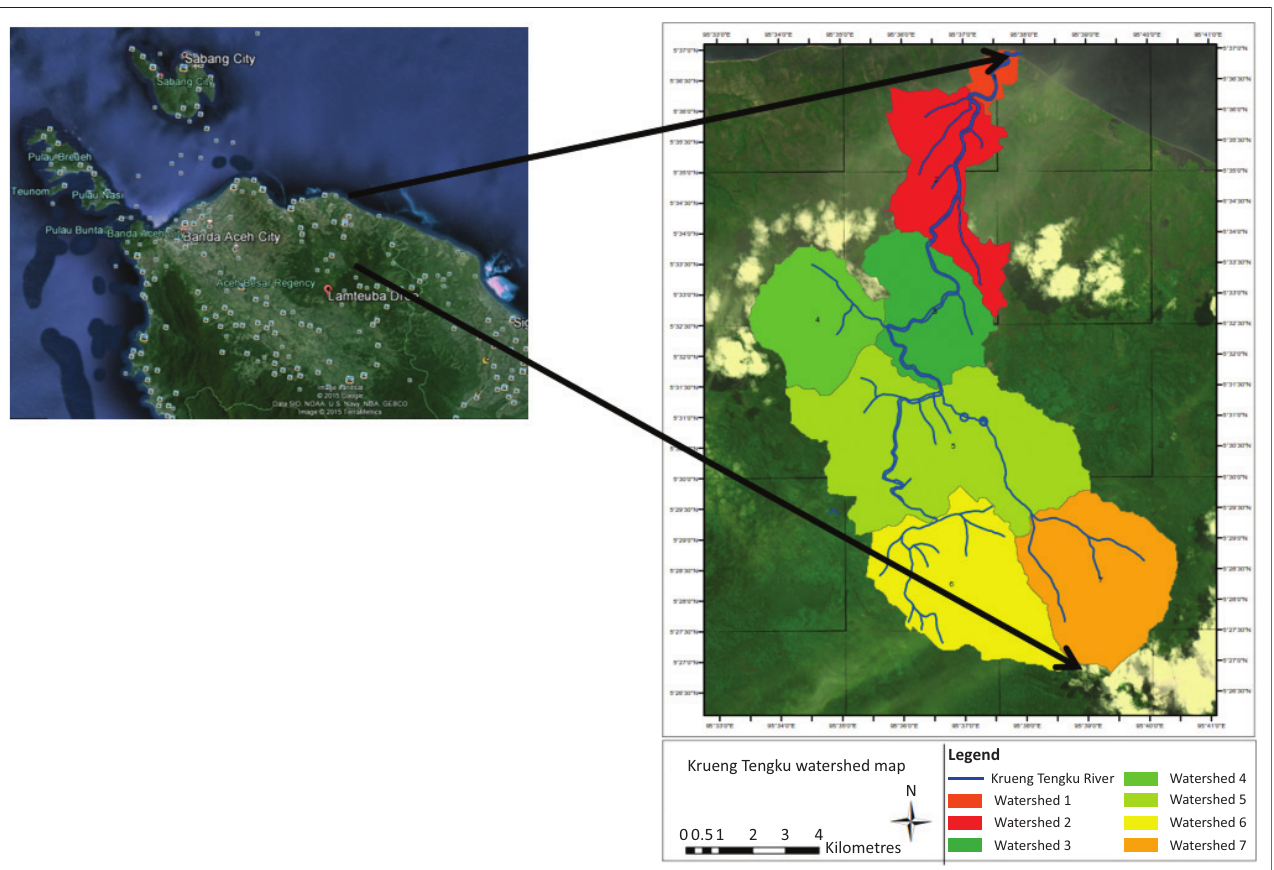
FIGURE 1: The Location of study – Krueng Teungku drainage